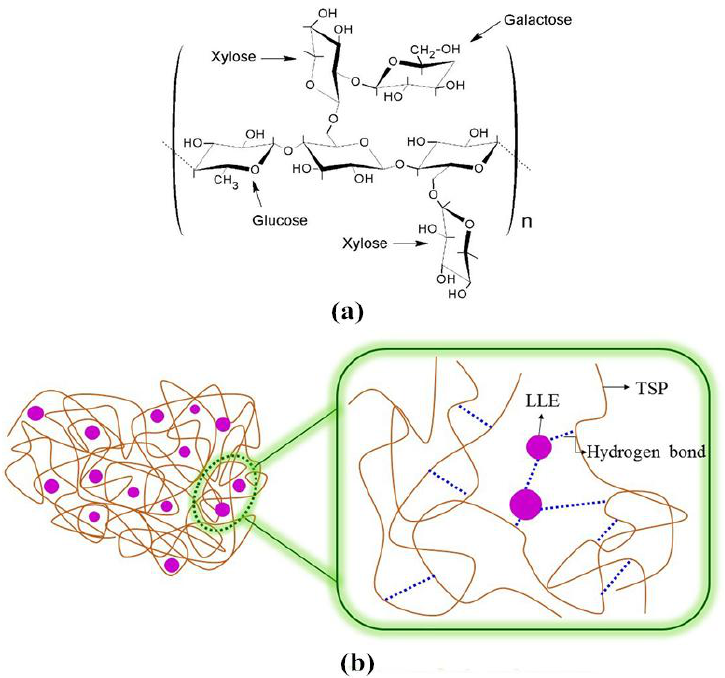
Figure 1. Structure of tamarind seed polysaccharide (TSP) ( a ) and schematic diagram of the TSP film after litmus lichen extract (LLE) addition ( b ).